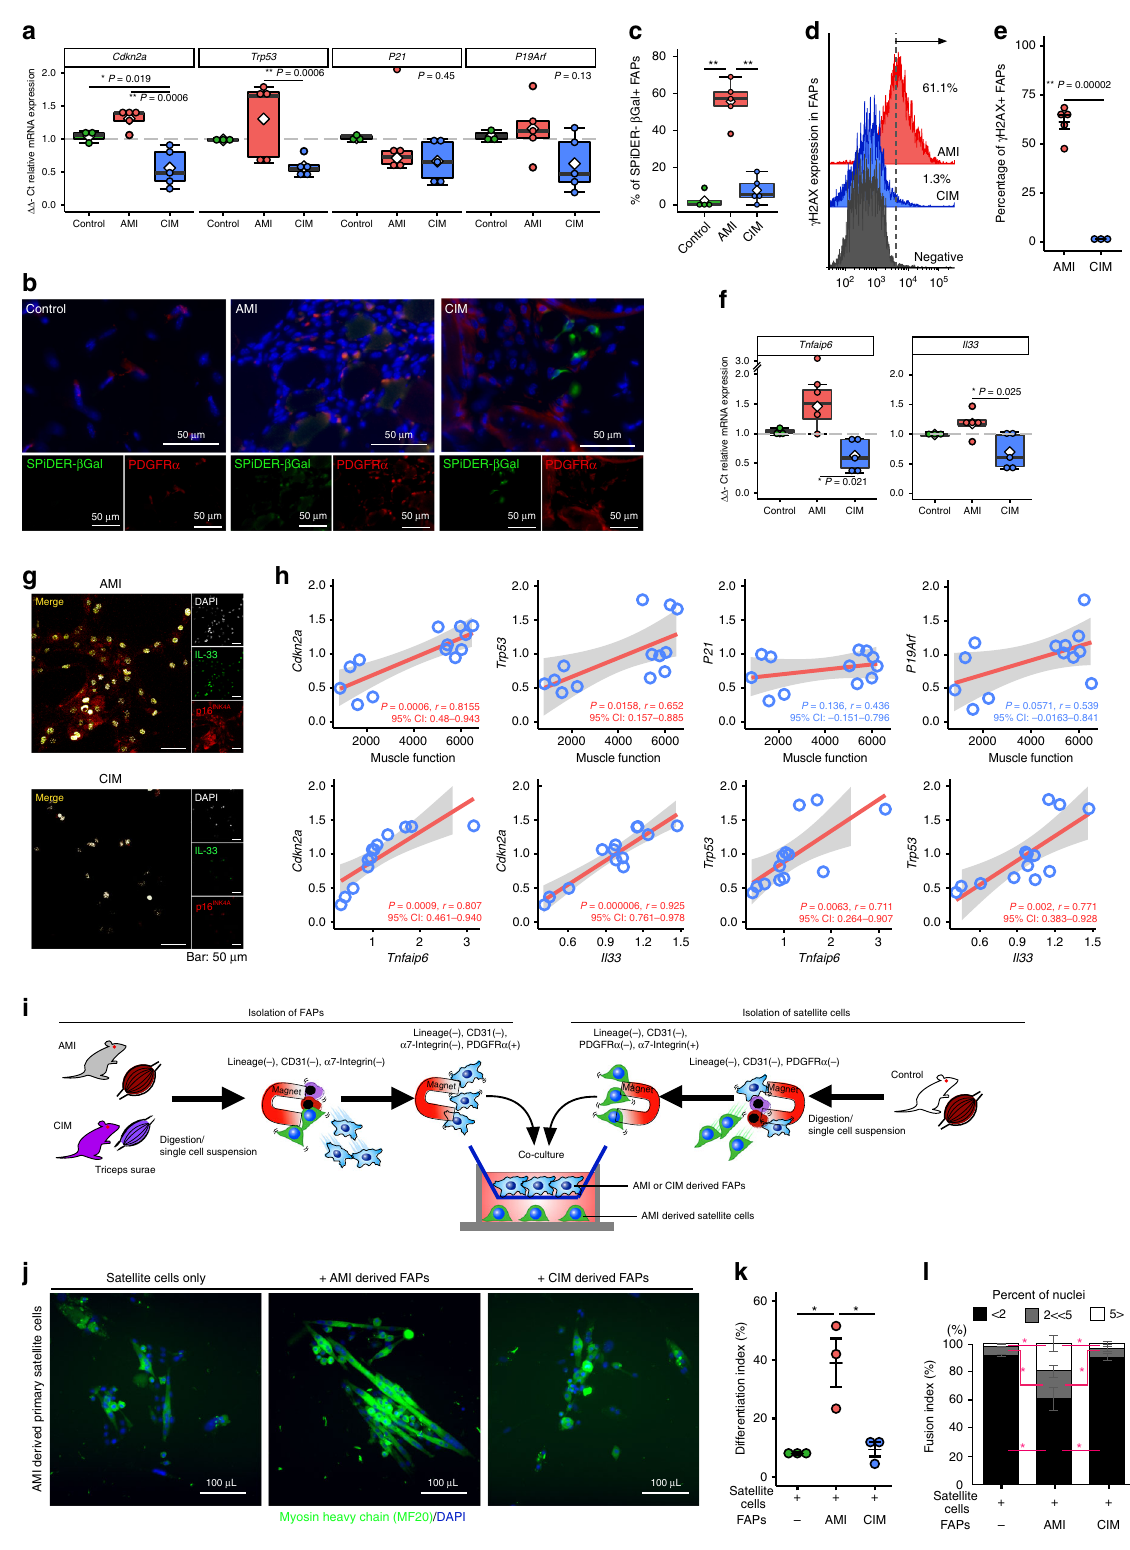
AICAR mice showed dramatically increased muscle function and muscle cross-sectional area, similar to the fi ndings in control- sedentary mice, and regenerating muscle fi bers also increased (Figs. 6b and 5f). Although the number of FAPs was not decreased, the percentage of p16 INK4A + FAPs and SPiDER- β - gal + FAPs was increased compared with baseline CIM